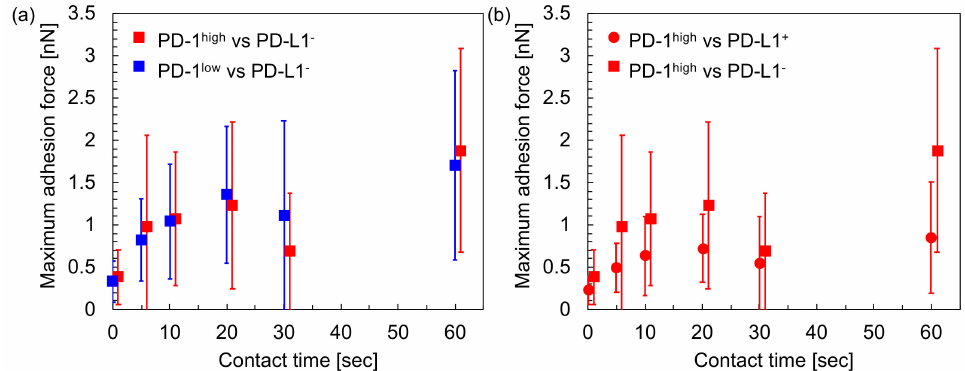
Figure 5. Summary of the intercellular adhesion force of T cells to PD-L1 − cancer cells. ( a ) Relationship between maximum adhesion forces and the contact time between PD-L1 − cancer cells and either PD-1 high (red) or PD-1 low (blue) T cells. p > 0.05 for all contact times. ( b ) Comparison of the adhesion force of PD-1 high T cells to PD-L1 + (circle, same data in Figure 4) and PD-L1 − (square) cancer cells. Data points were shifted to left and right for visualization. p < 0.05 for all contact time.